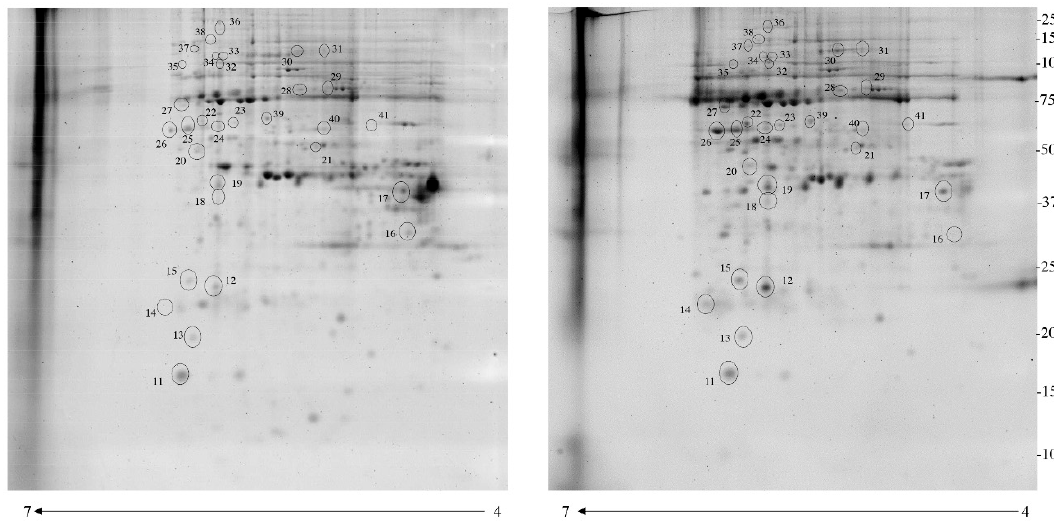
Figure 2. Two-dimensional electrophoresis map of normal myometrium and leiomyoma phosphoproteome enriched by IMAC columns. Immobilized pH gradient 4–7 strips were used for the first dimension and 12% polyacrylamide gel was used for the second dimension. The numbered circles indicate the differentially phosphorylated spots.